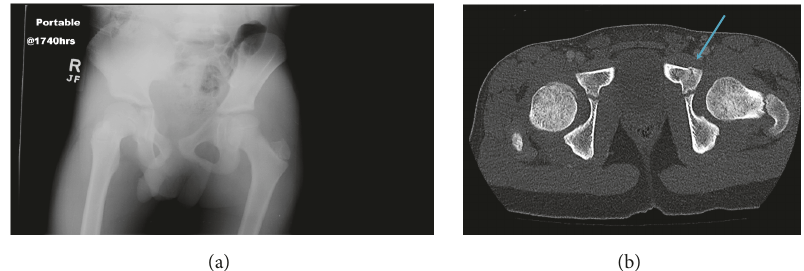
Figure 1: A portable radiograph of the pelvis (a) was performed on a 7-year-old male who was the victim of an automobile versus pedestrian trauma. No fracture or dislocation is seen on the radiograph. Twenty-nine minutes later, a contrast-enhanced CT of the abdomen and pelvis (b) was performed on the same patient demonstrating a nondisplaced left superior pubic ramus fracture (arrow).